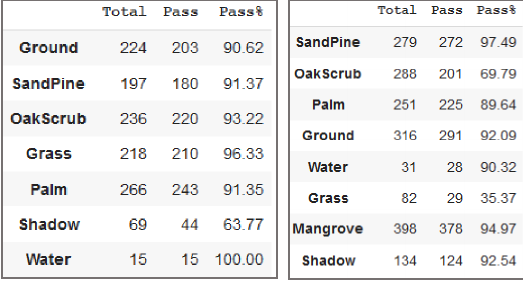
Figure 10: North (Right) & South (Left) Test